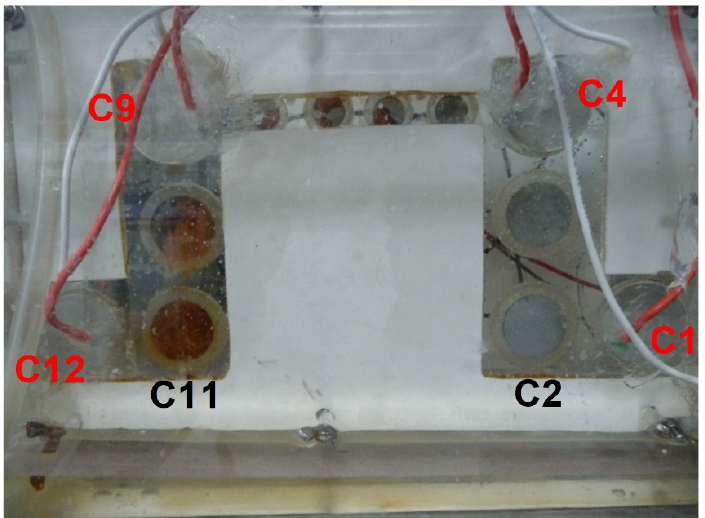
Figure 6. Image of the channel showing the surface of the steel coupons after 5 days of experiment. Coupons C1 (right of the image), C4, C9 and C12 are hidden by the corresponding counter-electrode set in the opposite side of the channel.